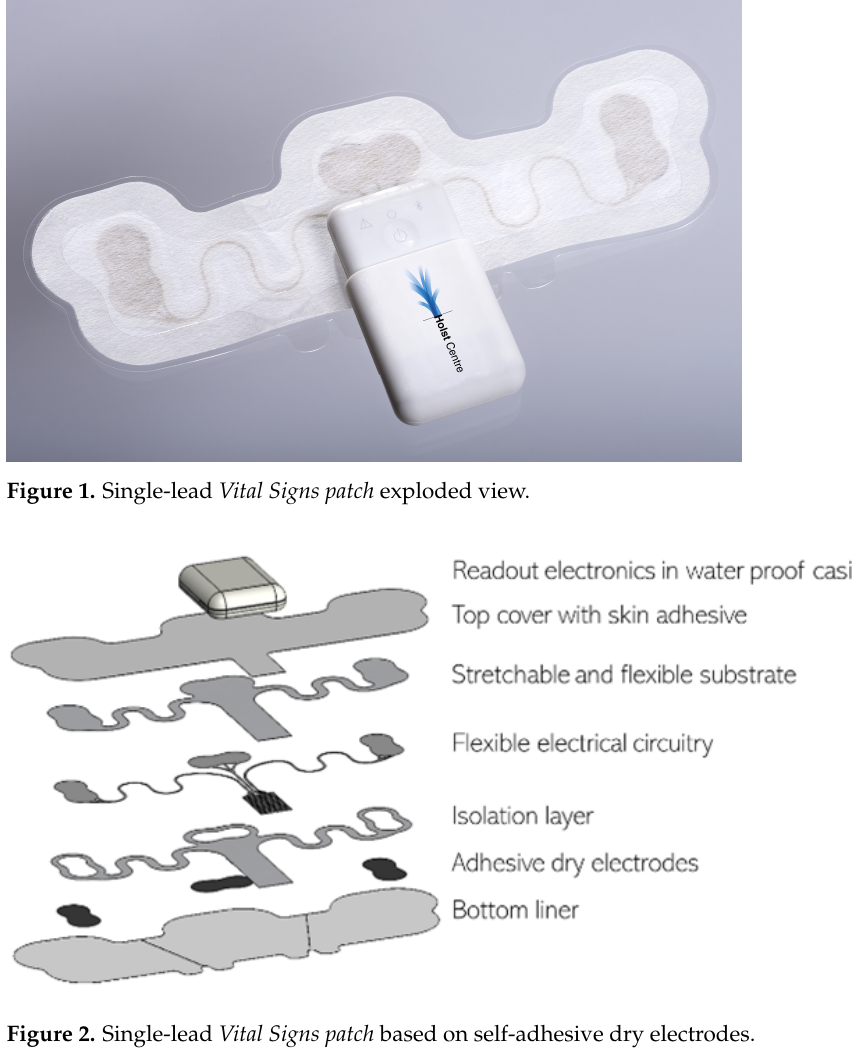
Figure 2. Single-lead Vital Signs patch based on self-adhesive dry